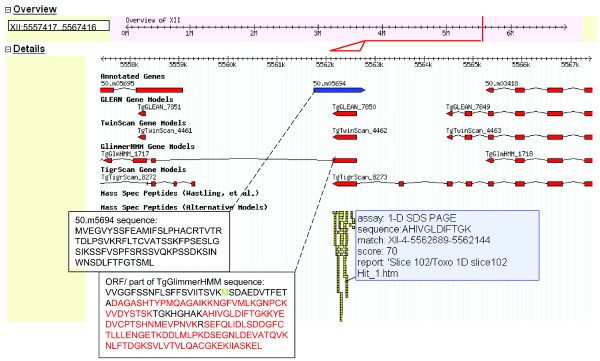
Peptide evidence indicating alternative frame shift. The position of ORF XII-4-5562689-5562144 in the genome scaffold is indicated by a red line on the grey track at the top of the figure and this region is expanded below, the red triangle demarking the ORF length. Predicted exons are indicated as red shaded boxes, linked by zigzag lines to indicate the position of exon/intron boundaries. Peptides aligning with this region are shown in yellow. The gene of interest with the release4 annotation (50.m05694) is highlighted in blue. Predicted sequences for this gene and the ORF and TgGlmHMM_1717 are shown as inserts. Sequence for which there is matching peptide evidence is shown in red. TgGlmHMM_1717 comprises several exons and the complete sequence is not given; the start methionine is shown in green. Mass spectrometric evidence for one peptide sequence derived by the 1-DE approach is shown.